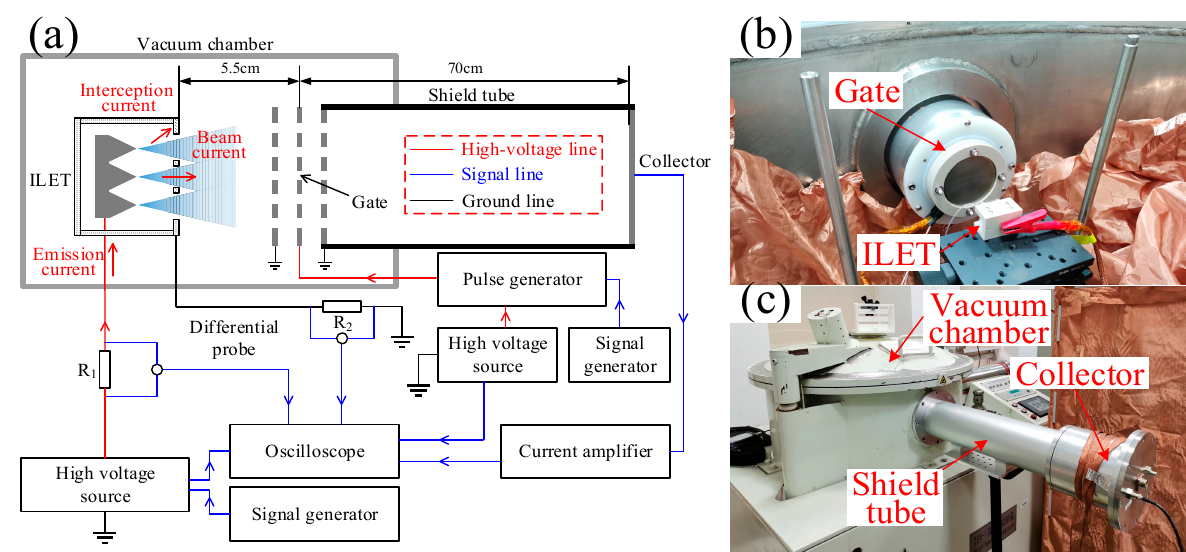
Figure 11. ( a ) Schematic diagram of experimental device, and image of the ( b ) inside and ( c ) outside of the vacuum chamber.